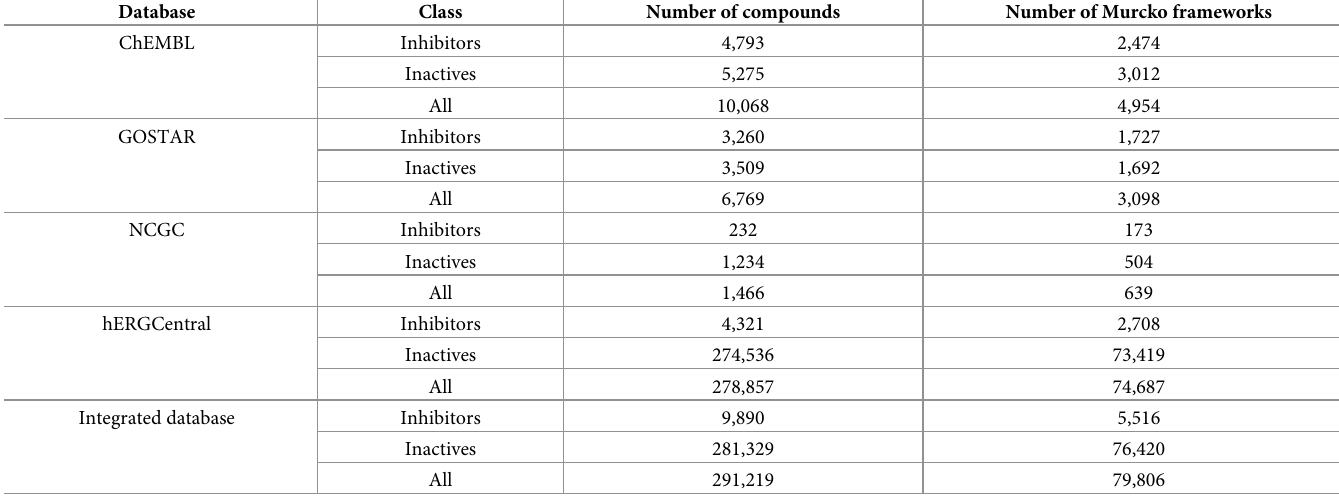
Table 1. The number of compounds and their Murcko frameworks in each database.